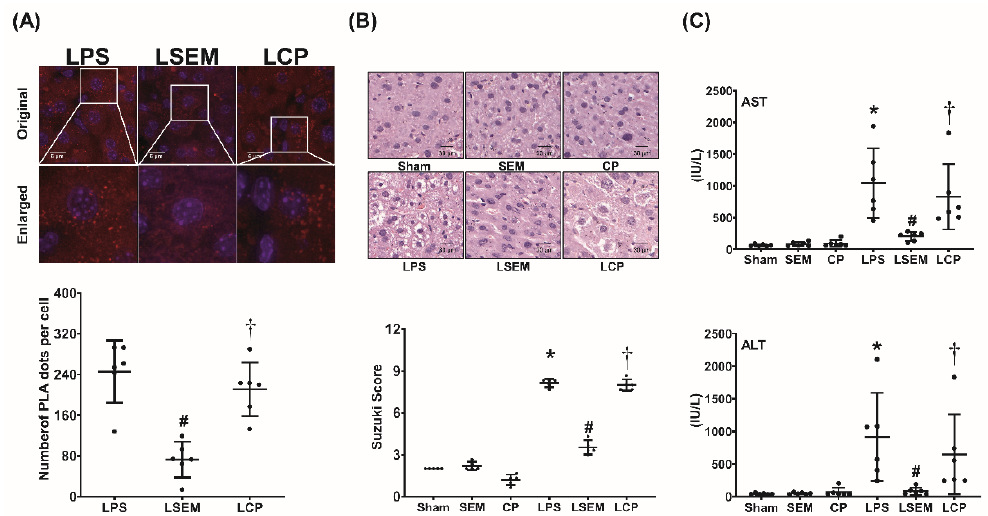
Figure 3. SEM18 peptide mitigates tumor necrosis factor (TNF)-α binding to TNF receptor 1 (TNFR1) and decreases liver injury induced by endotoxin. ( A ) Binding of TNF-α to TNFR1 in liver tissues, as measured at 24 h after lipopolysaccharide (LPS) or normal saline (NS) administration using immunofluorescence staining of proximity ligation assay (PLA). Red dots: positive PLA signal showing protein–protein interactions between TNF-α and TNFR1 in liver tissues. Blue dots: DAPI (4′,6-diamidino-2-phenylindole) stain showing a cell nucleus in liver tissues. ( B ) Representative microscopic findings of the liver tissues stained with hematoxylin–eosin (200×) and the organ injury scores (Suzuki’s scores), as measured at 24 h after LPS or NS administration. ( C ) Plasma concentrations of aspartate aminotransferase (AST) and alanine aminotransferase (ALT), as measured at 24 h after LPS or NS administration. Sham: the NS group; SEM: the NS plus SEM18 peptide group; CP: the NS plus control peptide (CP) group; LPS: the LPS (15 mg/kg) group; LSEM: the LPS (15 mg/kg) plus SEM18 peptide group; LCP: the LPS (15 mg/kg) plus CP group. Data are presented as the mean ± standard deviation. Data related to PLA, microscopic findings, Suzuki’s score, AST, and ALT were derived from five, five, six, and six mice from each group, respectively. * p < 0.05, the LPS group vs. the sham group; # p < 0.05, the LSEM group vs. the LPS group; † p < 0.05, the LCP group vs. the LSEM